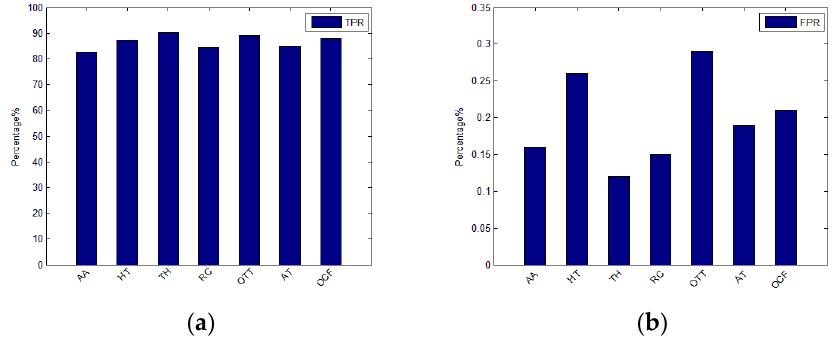
Figure 12. Evaluation LICM module detection result; (a) true-positive rate (TPR); (b) FPR.